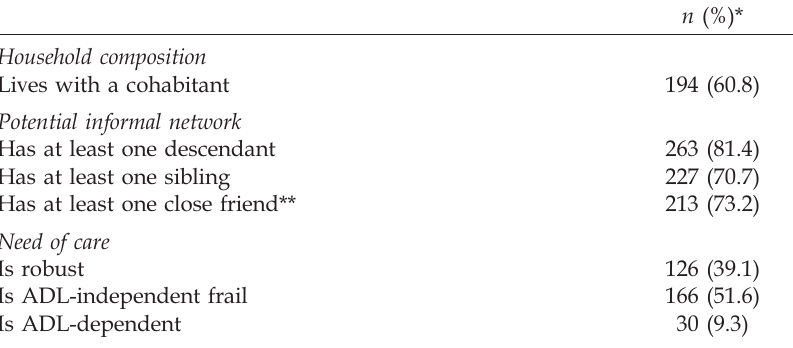
Table 2. Characteristics at baseline ( n (cid:1) 323)